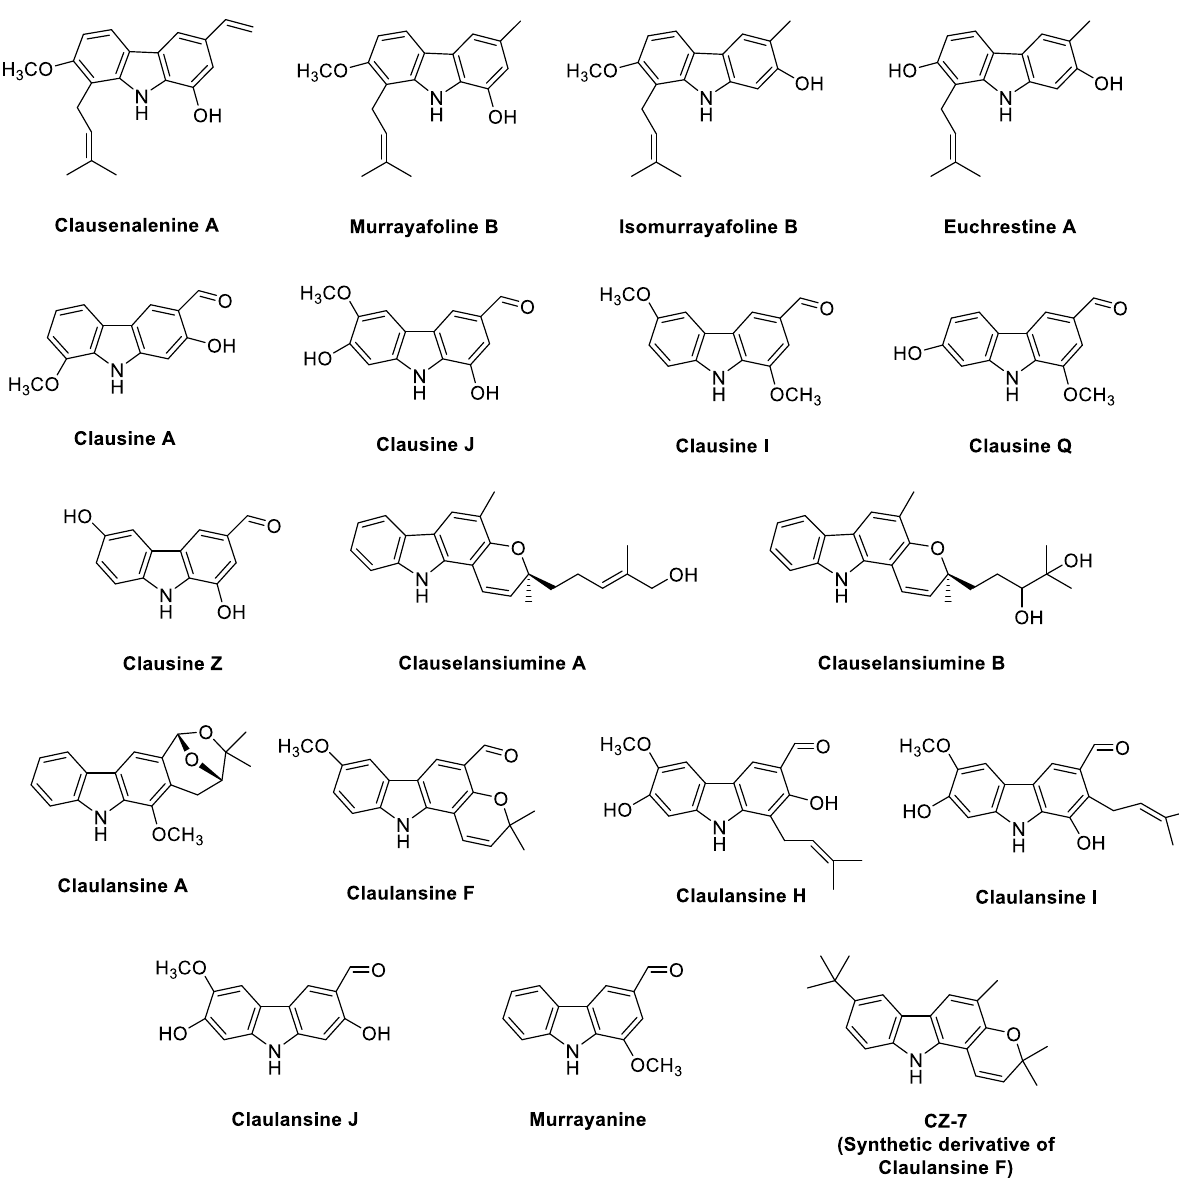
Figure 3. Potential neuroprotective phyto-carbazole alkaloids from the species of the genus Clausena .